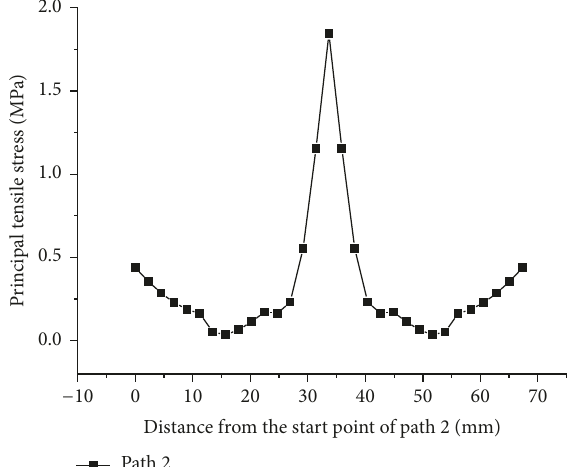
Figure 34: Principal tensile stress in the concrete specimen prestressed under a load of 10MPa when the displacement resulting from corrosion-induced expansion reaches 0.031 mm.